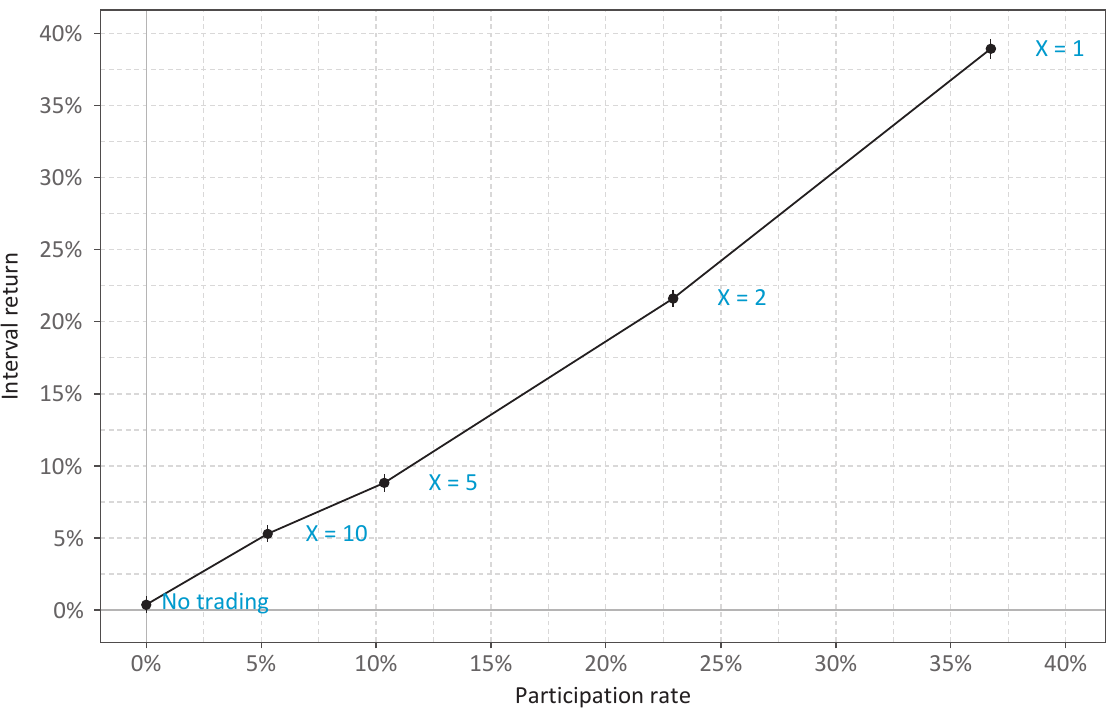
Figure 5. Market impact as a function of metaorder participation rate